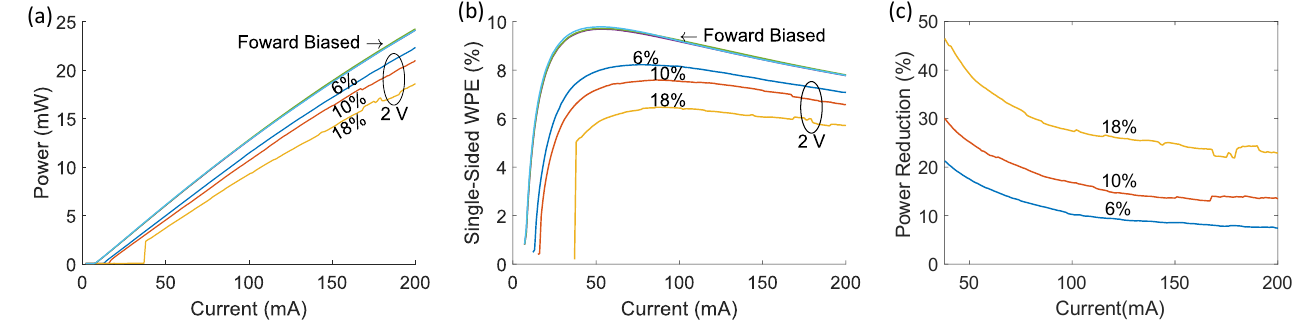
Figure 3. Comparison of 3rd harmonic quantum dot colliding pulse mode-locked lasers (CPMLLs). ( a ) Light–current and ( b ) single-sided wall plug efficiency curves with saturable absorber (SA), biased in parallel with the gain section (forward-biased), and reverse-biased at 2 V (circled curves). The three forward-biased curves in ( a , b ) are hard to distinguish, because the performance is similar. ( c ) The percent reduction in power from reverse biasing the SA. SA lengths are labeled on the curves as a total fraction of the cavity